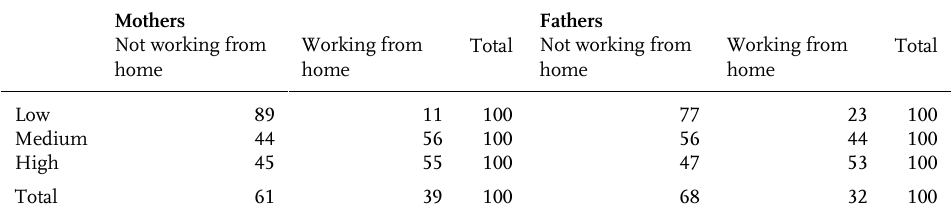
Table A4: Working from home by level of education, April and May 2020, in % Mothers Fathers Not working from